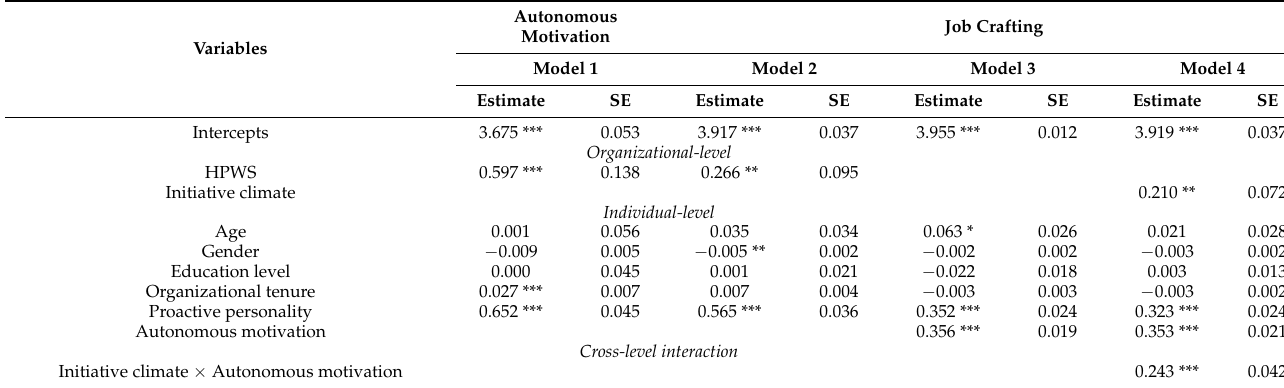
Table 3. Multilevel path analysis results.